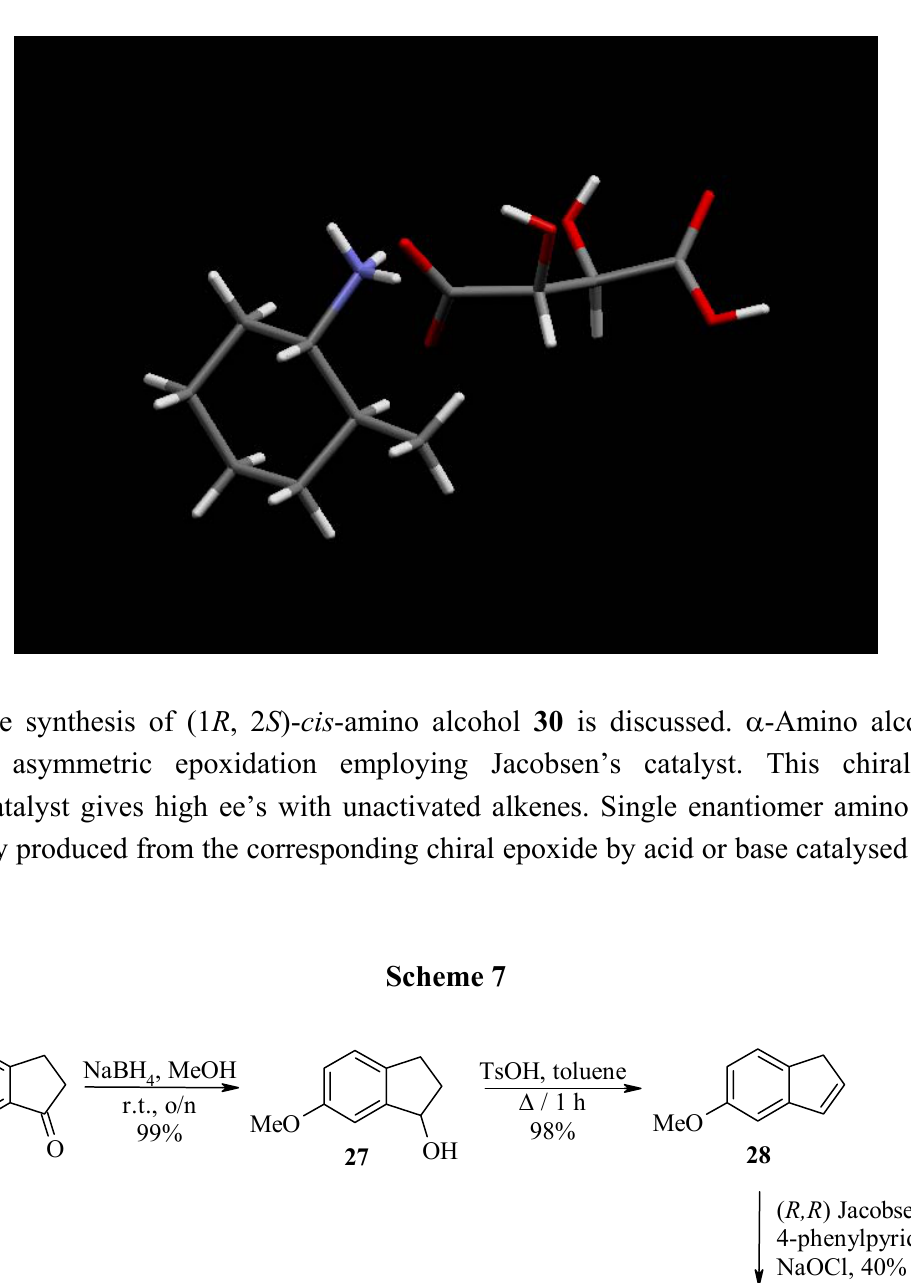
Figure 3. X-ray structure of ( R,R )-(+)-tartaric acid salt of 25